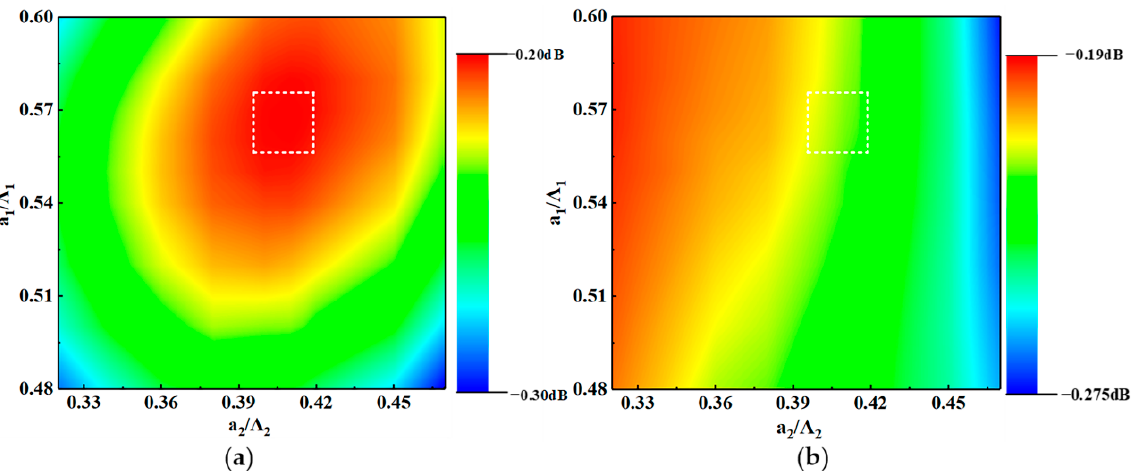
Figure 5. ( a ) PCL and ( b ) IL of the PSR for the TE mode and TM mode with different a 1 / Λ 1 and a 2 / Λ 2 . When the value of the duty cycle was within the white dashed box, the overall performance of the device was better.